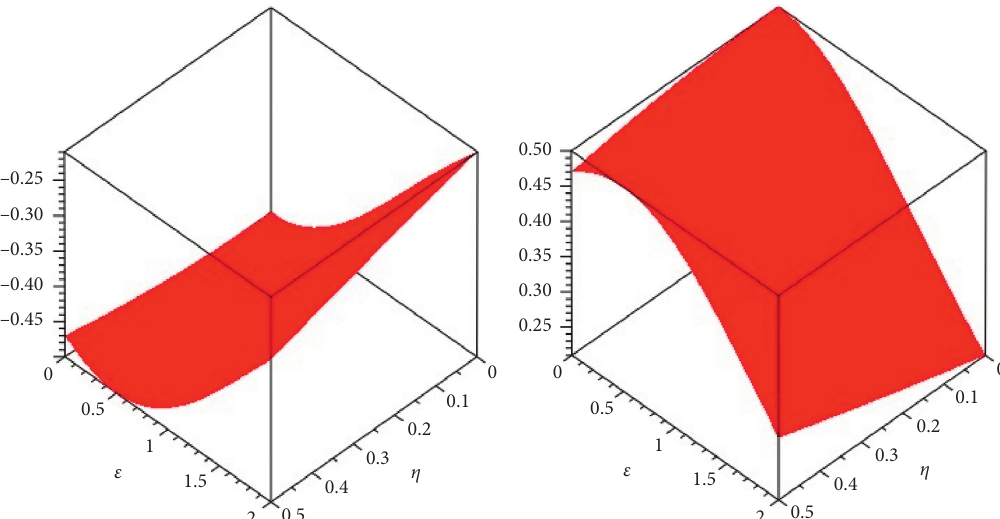
Figure 3: Upper and lower fuzzy figure of analytical solution of example 2.